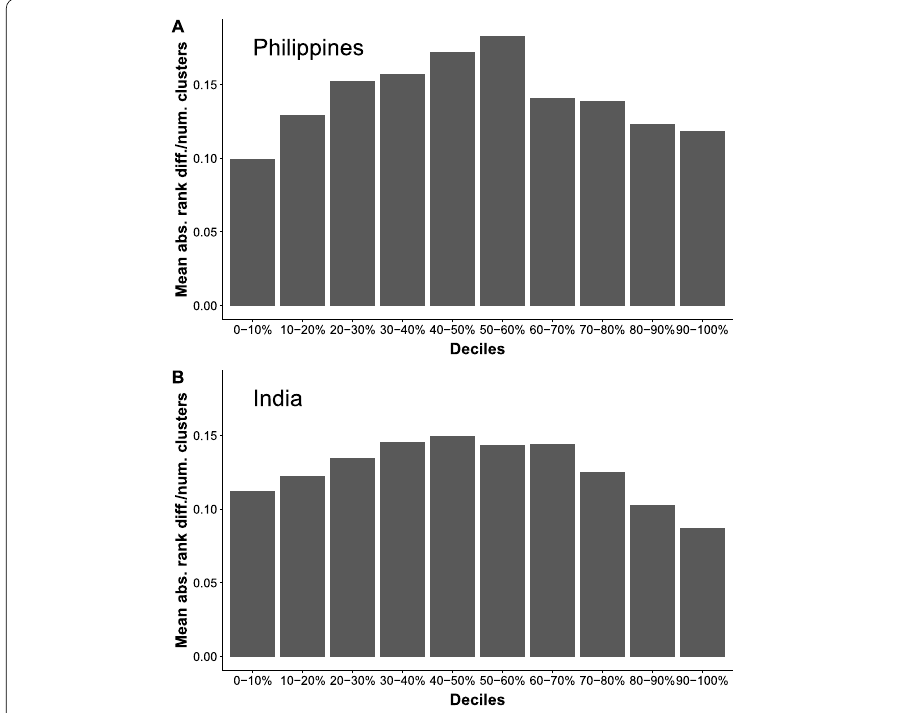
Figure 3 Performance of the models across the distribution of Wealth Index. Performance of the models for Philippines ( A ) and India ( B ) across the distribution of Wealth Index. For each cluster, the difference between its ranking when ordered according to the DHS wealth index versus when ordered according to predicted Wealth Index was calculated. The data was then split into deciles according to the DHS Wealth Index and the average absolute rank difference computed for each. The y-axis shows the mean absolute rank difference for clusters in that decile as a fraction of the total number of clusters in the dataset. The figures are based on cross-validated predictions from the tree model with Facebook features, log population density and regional indicators